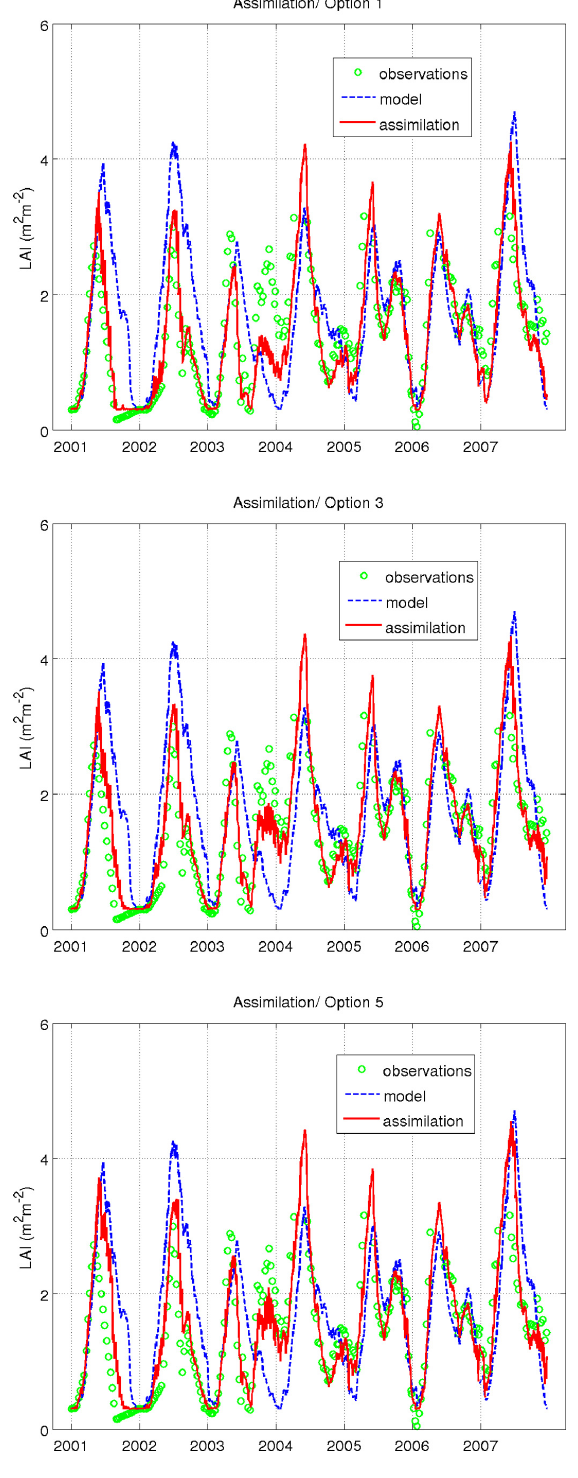
Fig. 4. Time series of observed, modeled and assimilated LAI (m 2 m − 2 ) for option 1 (top), option 3, (middle) and option 5 (bot- tom), from 2001 to 2007 for the SMOSREX grassland.